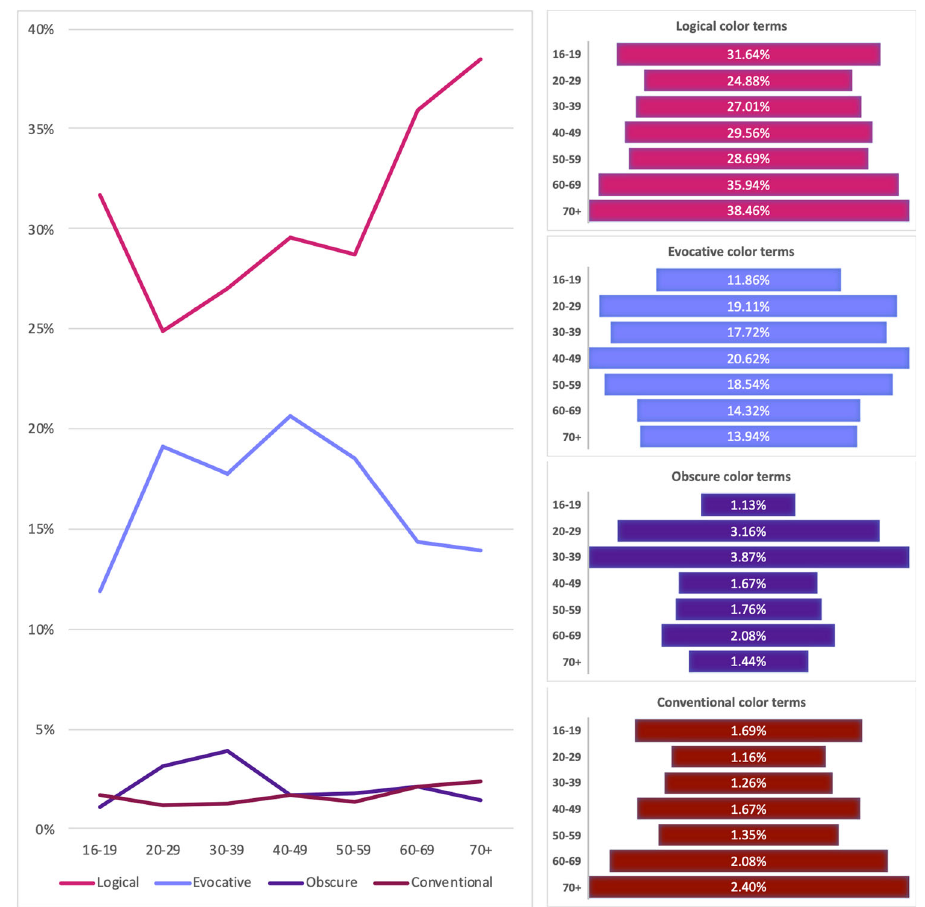
Fig. 10 Frequent Russian non-BCTs. Percentage of “ logical ” , “ evocative ” , “ obscure ” and “ conventional ” color terms in different age groups.